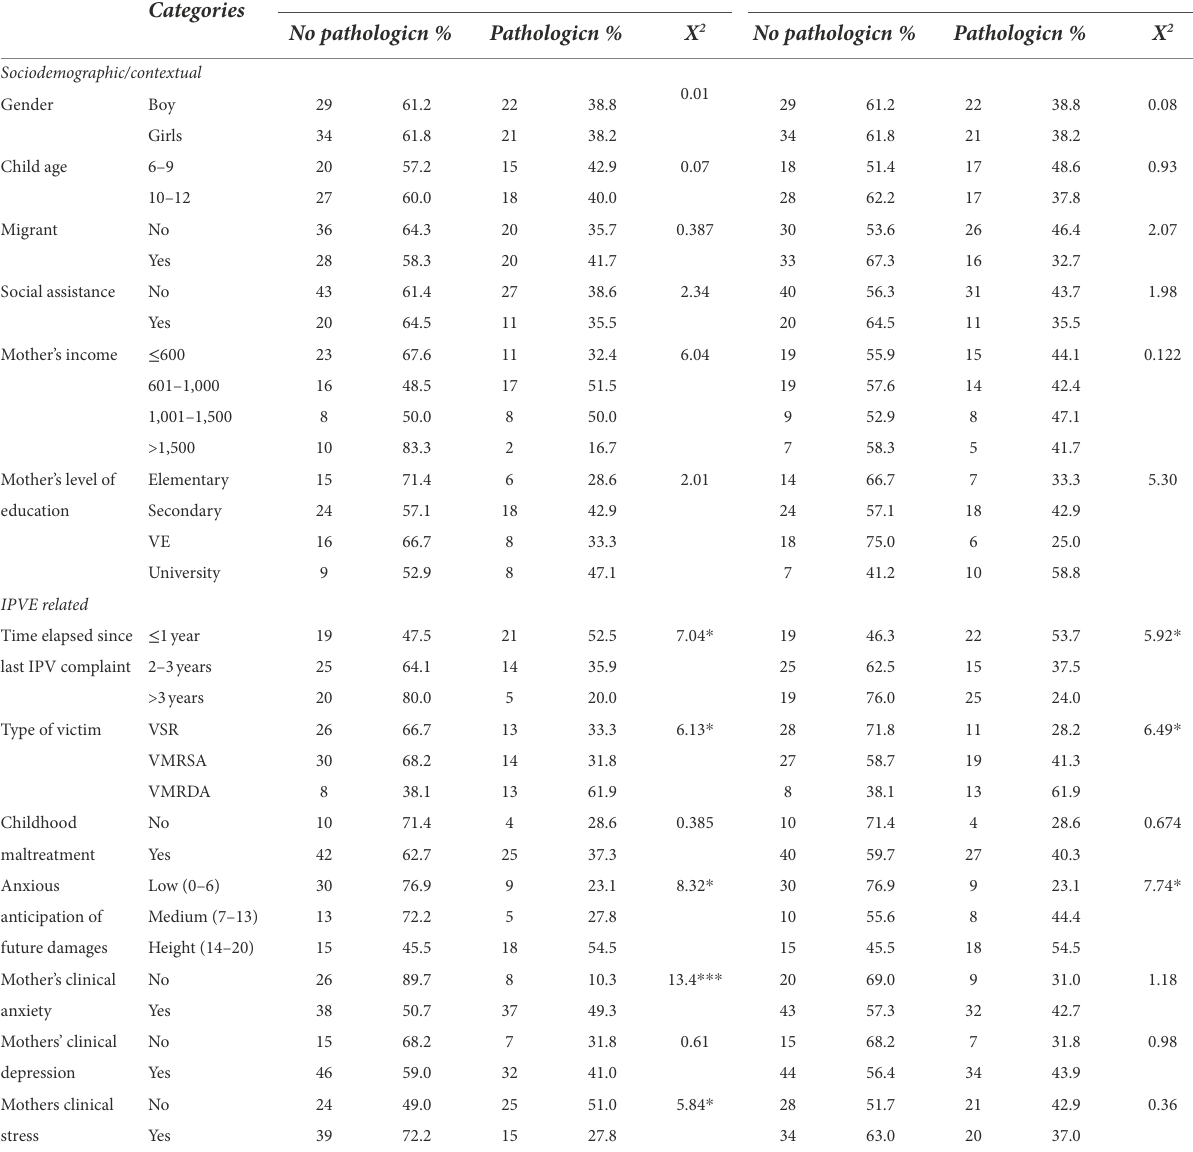
TABLE 2 Differences in children’s anxiety and depression related to sociodemographic/contextual and IPVE